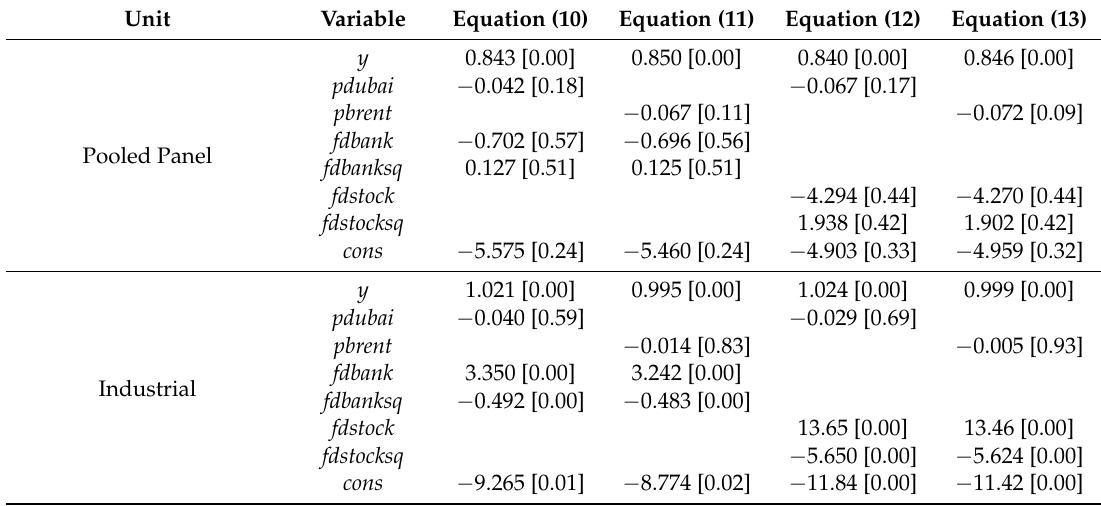
Table 7. MG results based on nonlinear